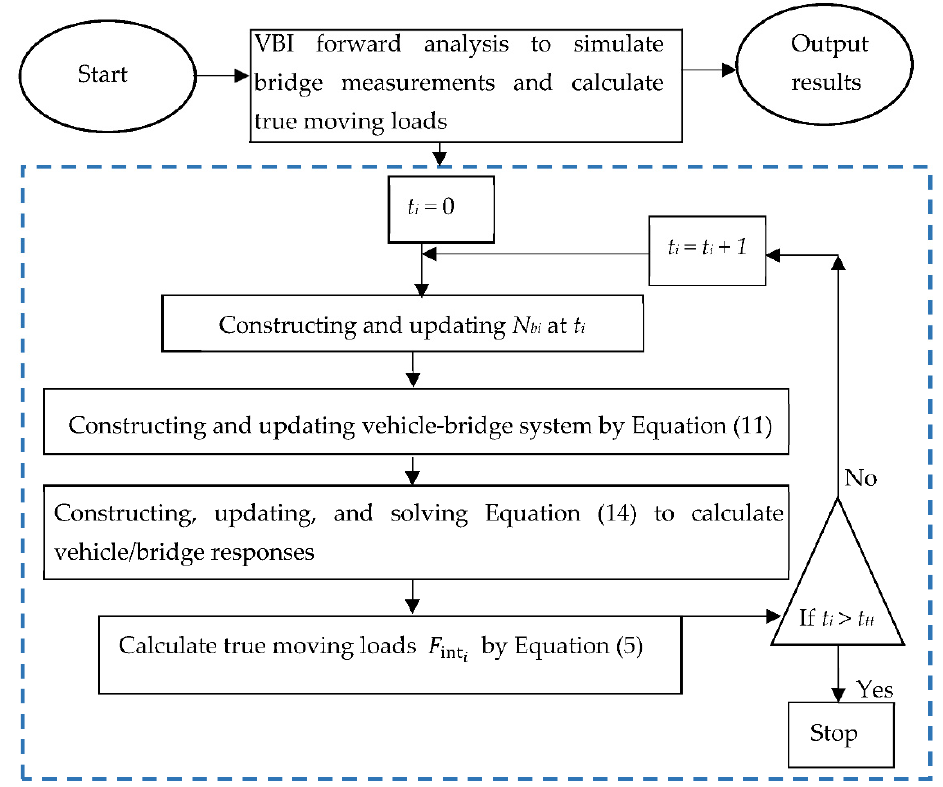
Figure 3. Calculating the vehicle/bridge responses and the true moving loads by the explicit form of Newmark- β method.